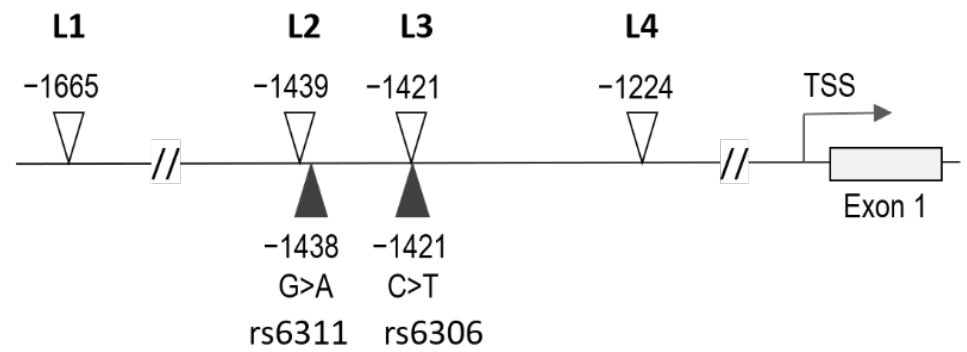
Figure 1. Schematic representation of the HTR2A promoter region. Positions of the analyzed methylation sites (L1, L2, L3, L4) are indicated by open triangles and those of the analyzed polymorphic sites (rs6311, rs6306) by closed triangles. Numbers refer to positions in bp relative to the ATG start codon in exon 1. The arrow indicates the major transcription start site (TSS).